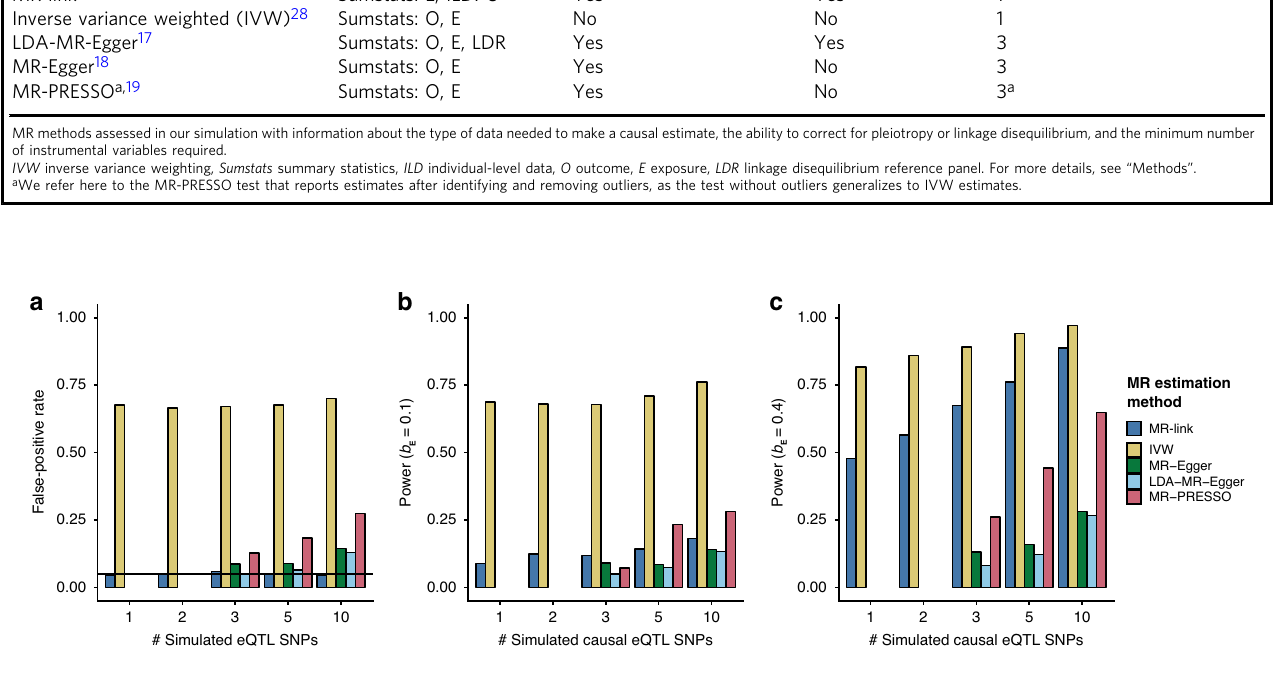
Fig. 3 Relative performance of different MR methods. The fi gure shows performance of MR methods on simulations representing the pleiotropy through linkage disequilibrium (LD) scenario (depicted in Fig. 2b) when 1, 3, 5, or 10 causal expression quantitative trait locus (eQTL) single nucleotide polymorphisms (SNPs) were simulated ( “ Methods ” ). a False positive rates (at alpha = 0.05) in scenarios where no causal relationship is simulated. b Power to detect a small causal effect (at alpha = 0.05). c Power to detect a large causal effect (at alpha = 0.05). Note that MR-link is the only MR method that can adjust for pleiotropy when only one or two instrumental variables are available. MR methods that had fewer than 100 out of 1500 estimates in a scenario are not shown ( “ Methods ” ). Extended results, including those that are not shown in the fi gure, can be found in Supplementary Data